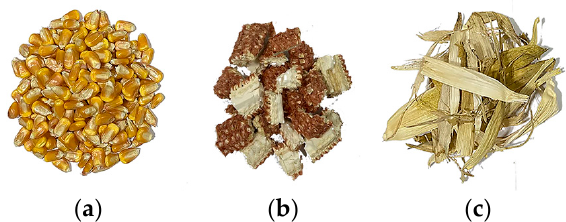
Figure 5. Components of corn threshed mixture. ( a ) Corn kernel, ( b ) Corn cob, ( c ) Corn husk.